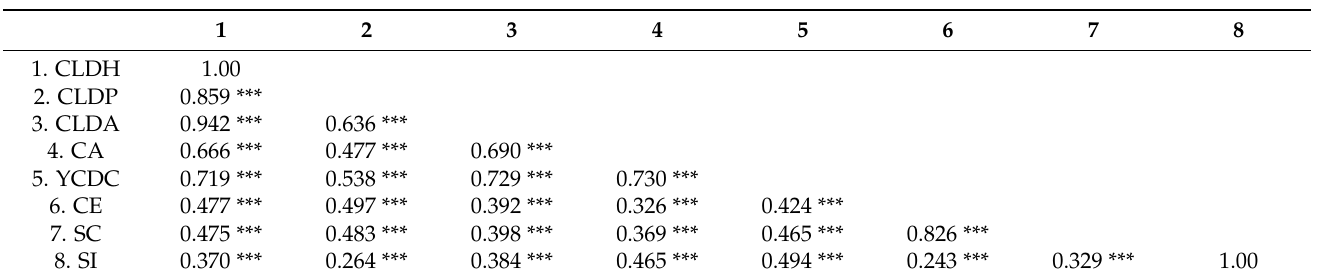
Table 4. Correlations between CLDH scale and its subscales with career-related and social well- being